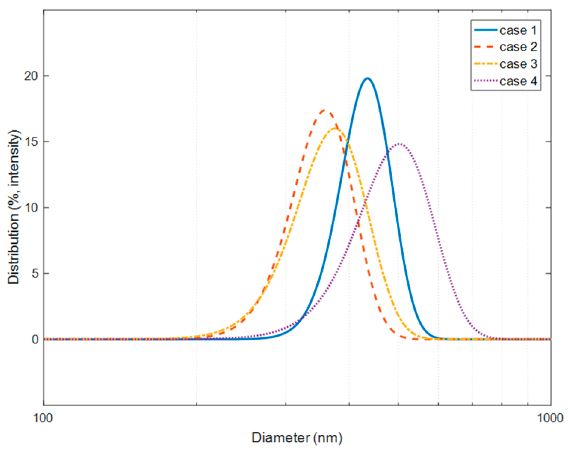
Figure 5. Particle sizes of synthesized silica distributions. No added phenol-formaldehyde resin (Case 1); 0.027 g of added phenol-formaldehyde resin (Case 2); 0.030 g of added phenol-formaldehyde resin